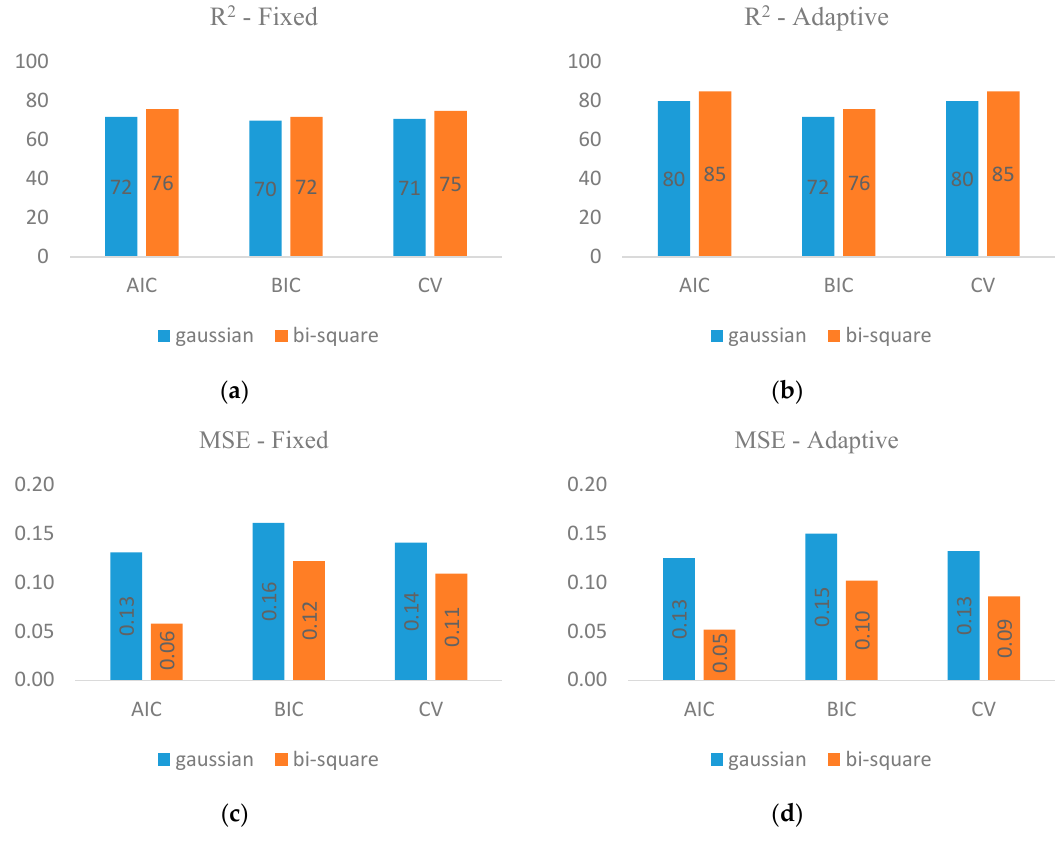
Figure 4. Estimated R 2 using fixed ( a ) and adaptive ( b ) kernels, calculated MSE using fixed ( c ) and adaptive ( d ) kernels.